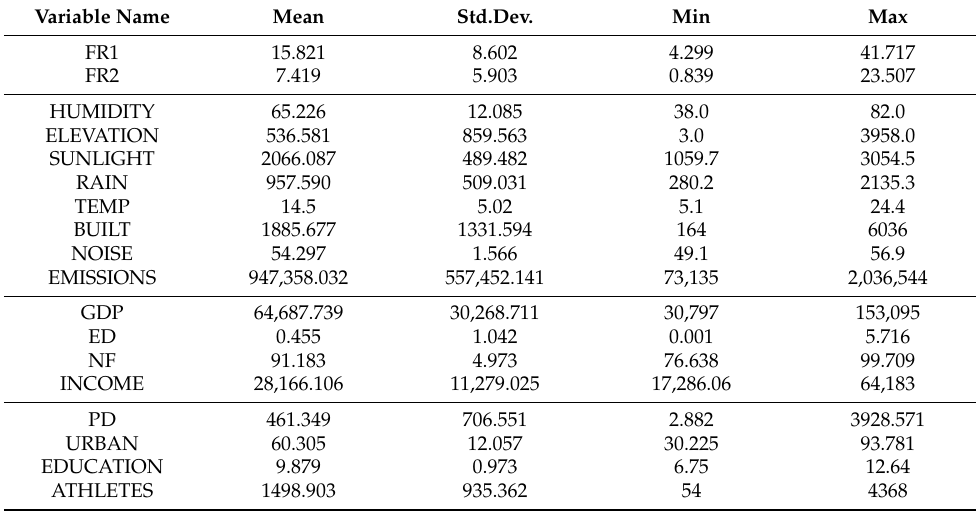
Table 2. Description and descriptive statistics of all the